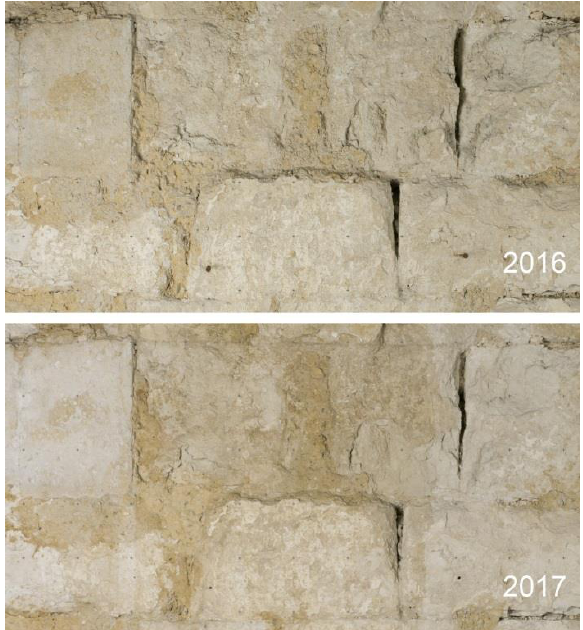
Figure 12. Trial area 3 at Santa Maria de Vitoria. Detail of the VIS photography. Comparison of 2016 (top) and 2017 (bottom)